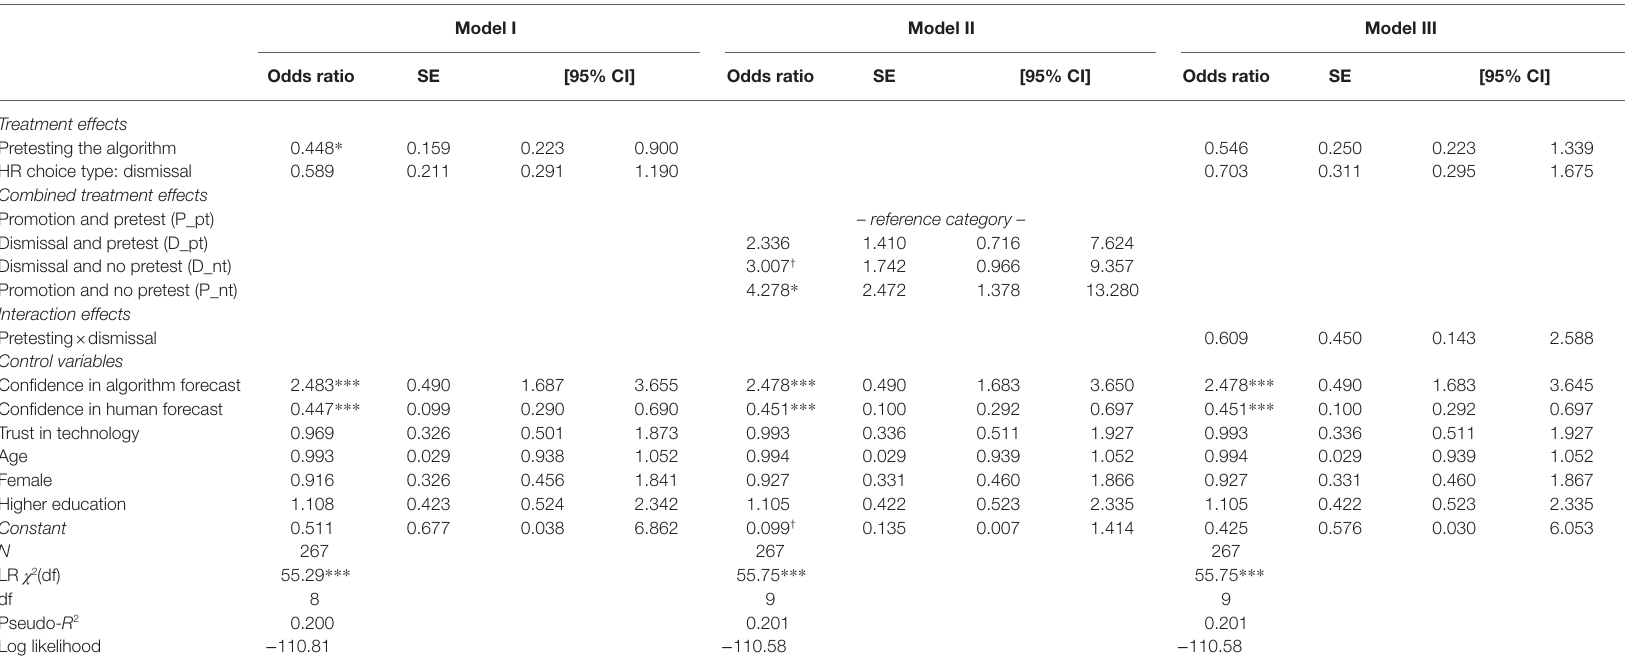
TABLE 3 | Logistic regression results on choice to delegate HR decision to